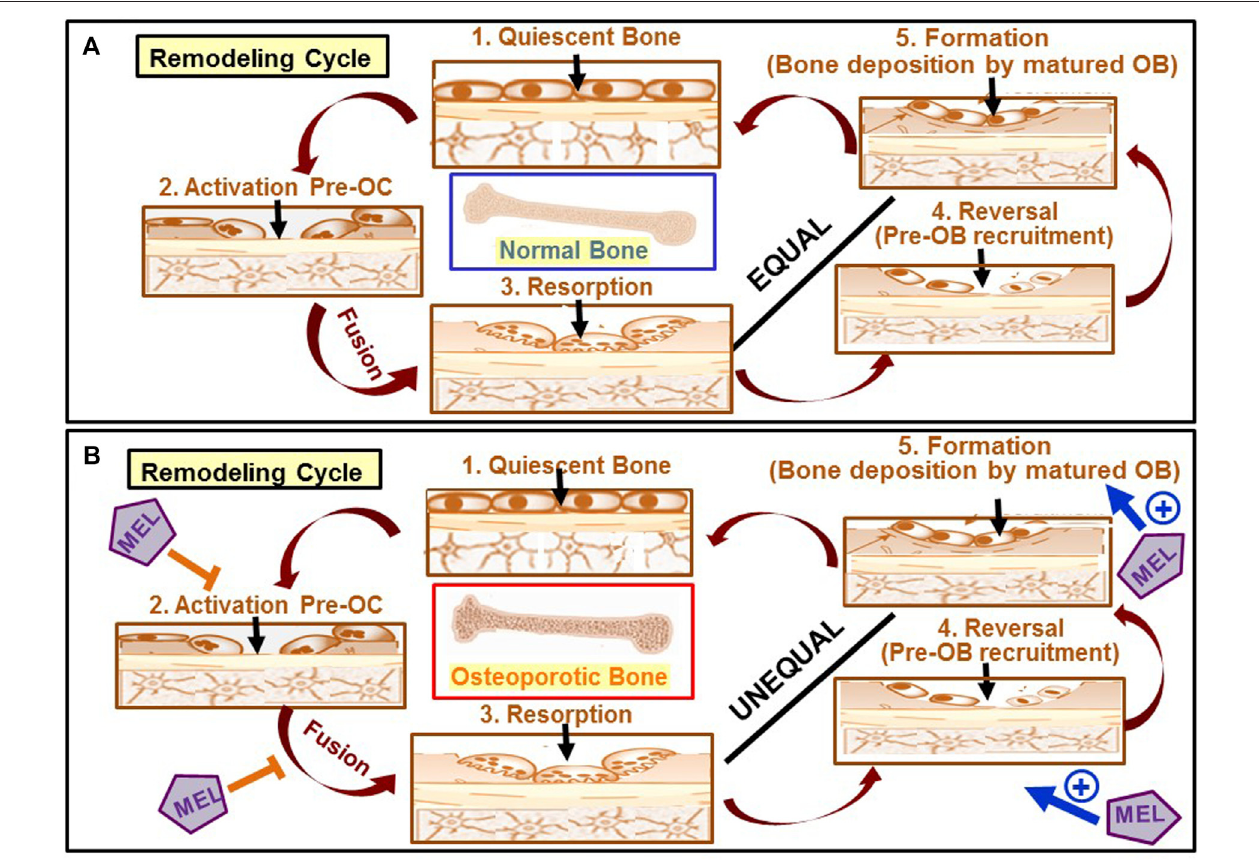
FIGURE3| Schematic diagram showing thepathogenesis ofosteoporosis and thesites ofaction ofMel. (A) Optimumbiomechanical function ofbone isachieved by removing old bone and subsequent replacement by new bone through a bone remodeling cycle. In healthy adults, the remodeling cycle begins fi rst by removing old/ damagedbonesbymultinucleatedosteoclasts(OC)(stage3)bythefusionofmononuclearosteoclastprecursorssuchasmonocytesandmacrophagesintheactivation phase (stage 2). Pre-osteoblasts formed from MSCs are then recruited to the resorption sites (stage 4), an event known as the reversal stage, followed by their differentiationtoosteoblast(OB)thatthenformnewbones(stage5)to fi lltheresorptionpits.Theamountofboneformedinhealthyadultsisnearlyequaltotheamountof bone resorbed. (B) In women with postmenopausal osteoporosis, while bone resorption becomes exaggerated (indicated as an unequal relationship between stage 3 andstage4)duetotheactivationofosteoclastsasaresultofafallinestrogenlevel,boneformationisconcurrentlydiminishedduetoafallinosteoblastdifferentiationand survival. Mel favorably acts at four stages of the remodeling, inhibits resorption (stages 2 and 3), and promotes bone formation (stages 4 and 5).